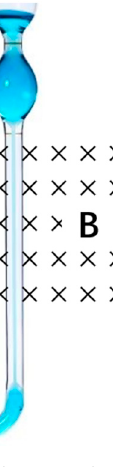
Figure 1. Schematic diagram of the magnetic field viscosity testing device (B is magnetic flux den- sity ).